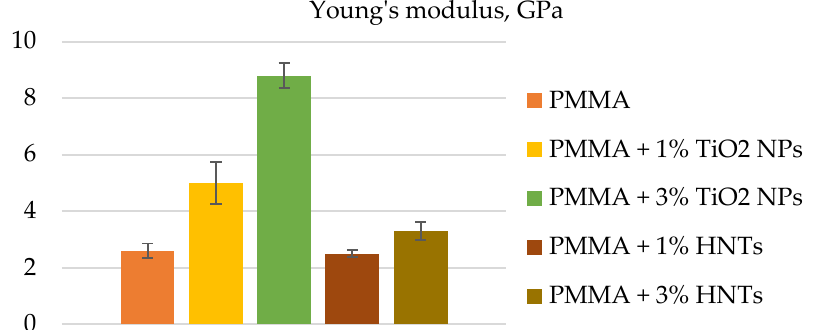
Figure 4. The mean value and its standard deviation of Young’s modulus, evaluated for control (PMMA), PMMA + 1% TiO 2 NPs, PMMA + 3% TiO 2 NPs, PMMA + 1% HNTs, and PMMA + 3% HNTs, are represented. Reported results were considered statistically significant respect to control (PMMA) for a p -value < 0.005.